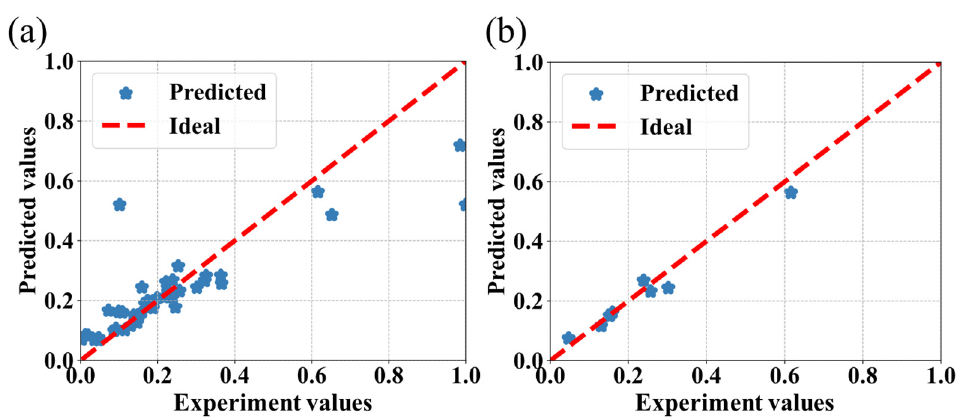
Figure 4. Performance of the CatBoost algorithm for the prediction of IBU loading capacity of MOFs associated with the experimental values. The values were predicted by the model, ( a ) with the entire dataset, and ( b ) with the testing dataset.